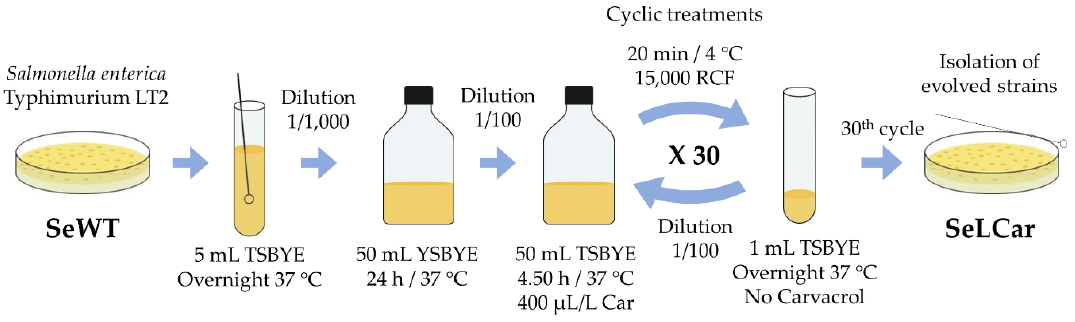
Figure 3. Diagram of evolution assay by short lethal treatments.